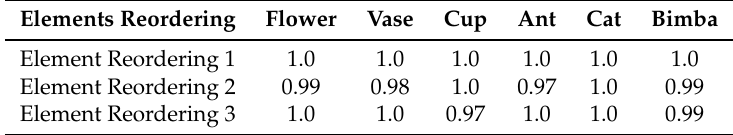
Table 7. Watermark robustness against element reordering measured in terms of correlation.